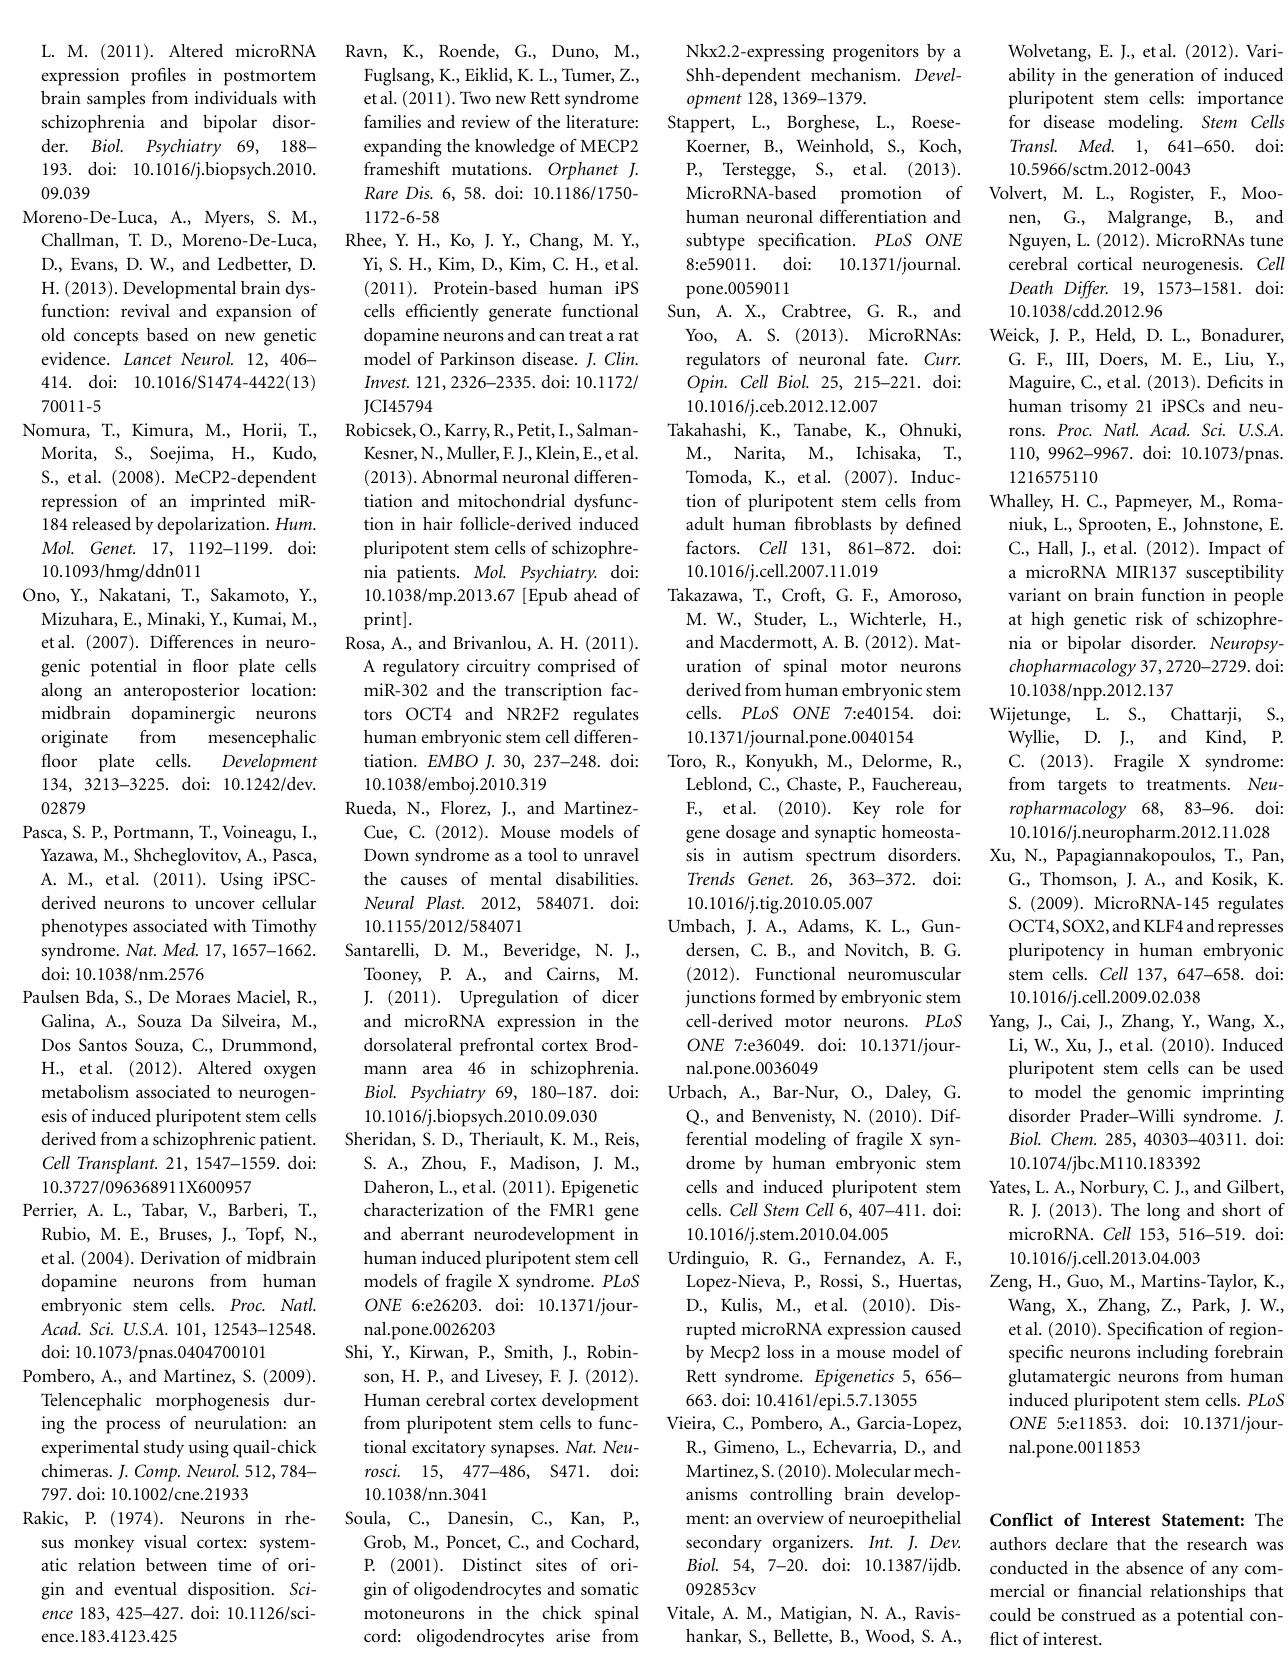
Conflict of Interest Statement: The authors declare that the research was conducted in the absence of any com- mercial or financial relationships that could be construed as a potential con- flict of